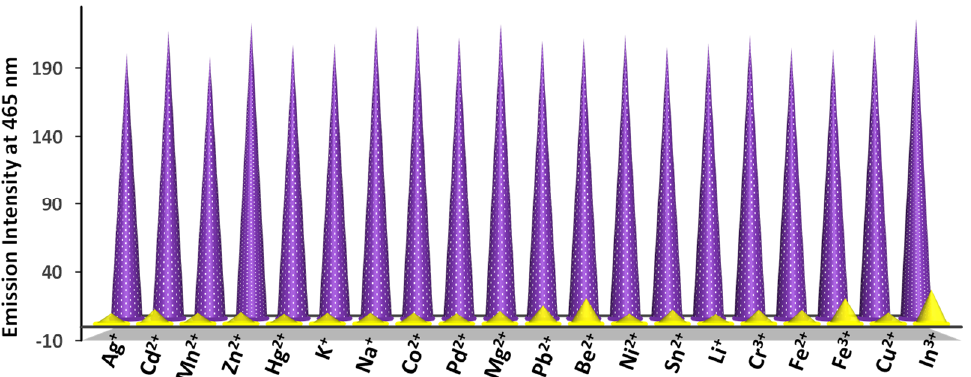
10 of 21 Figure 5 . Change in the emission spectra of L1 (c, 20 μM) on successive addition of ( a ) Al 3+ ion (0-75 μM) and ( b ) Ga 3+ ion (0-75 μM); ( c ) L2 (c, 20 μM) on successive addition of Ga 3+ ion (0-200 μM). Determination of binding constants by Benesi–Hildebrand plots for the detection of ( d ) Al 3+ ion, ( e ) Ga 3+ ion by L1 , and ( f ) Ga 3+ ion by L2 from the emission spectral profiles. Determination of detection limit of L1 towards the ( g ) Al 3+ ion, ( h ) Ga 3+ ion, and ( i ) L2 towards the Ga 3+ ion. All studies were carried out in EtOH. 3.6. Selectivity, Lifetime, and Quantum Yield Measurements For a chemosensor, selectivity towards a particular analyte is crucial as a chemosen- sor may have to identify a specific analyte in a competing environment [70,71]. Thus, the selectivity of L1 and L2 towards Al 3+ /Ga 3+ ions in the presence of other competing metal